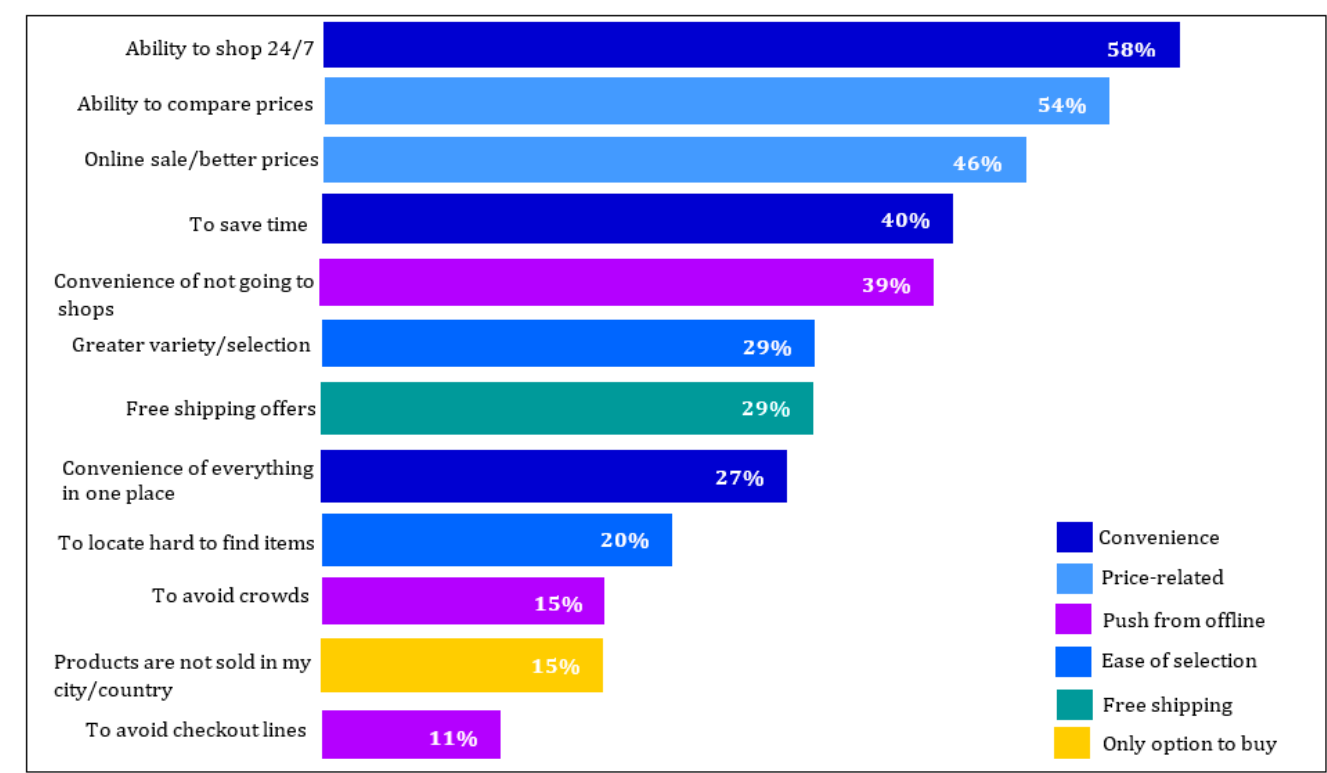
Figure 1. Some online shopping merits (www.smartinsights.com (accessed on 3 March 2022)).